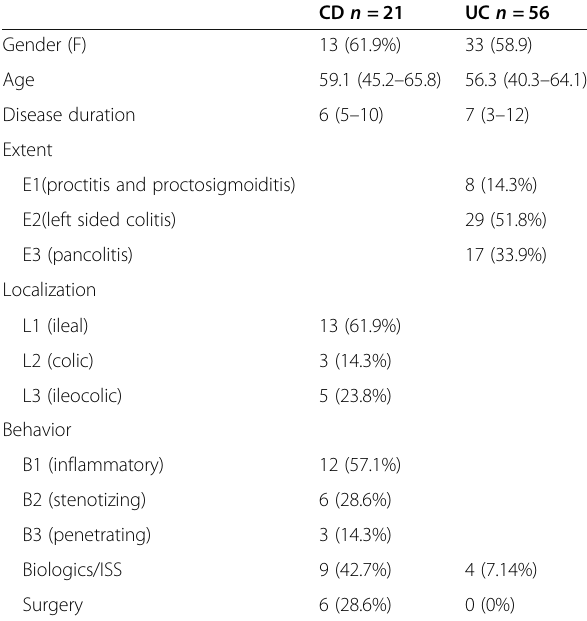
Table 1 Population characteristics. Data are expressed as n (%) or median (IQR)